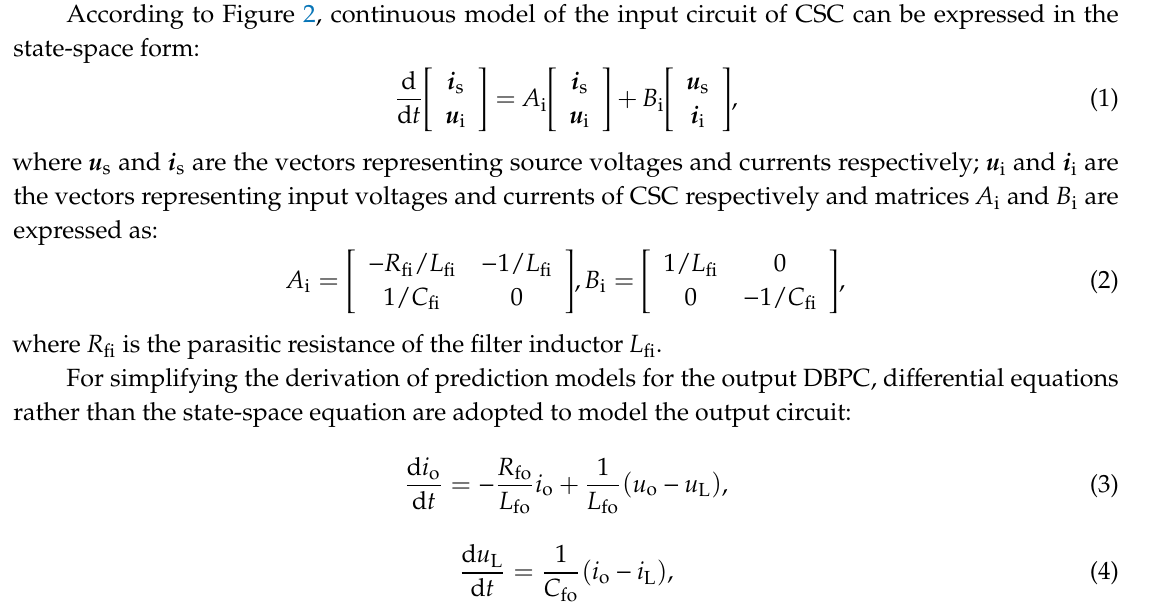
Figure 2. Schematic of the current source converter (CSC) system as the interface in aircraft DC microgrid (MG). 106